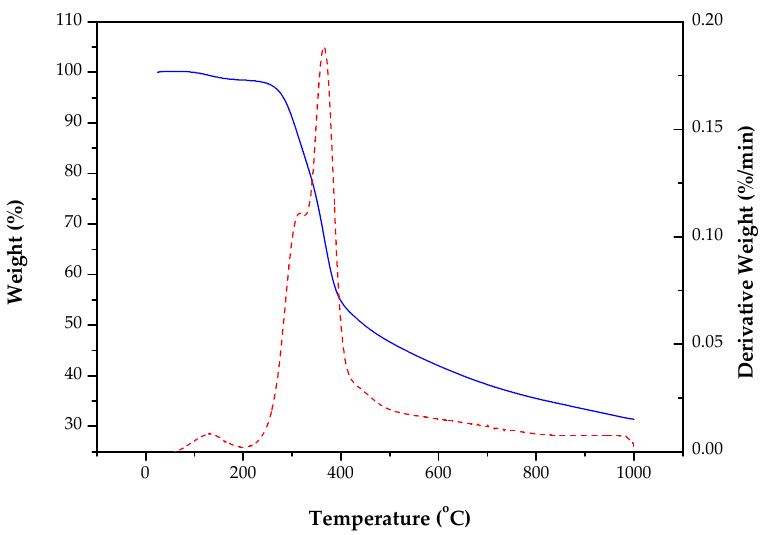
Figure 1. Thermogravimetric analysis (TGA) curve (blue color) and derivative thermogravimetry (DTG) curve (red dash line) of rice husk (RH) at a heating rate of 10 °C/min.